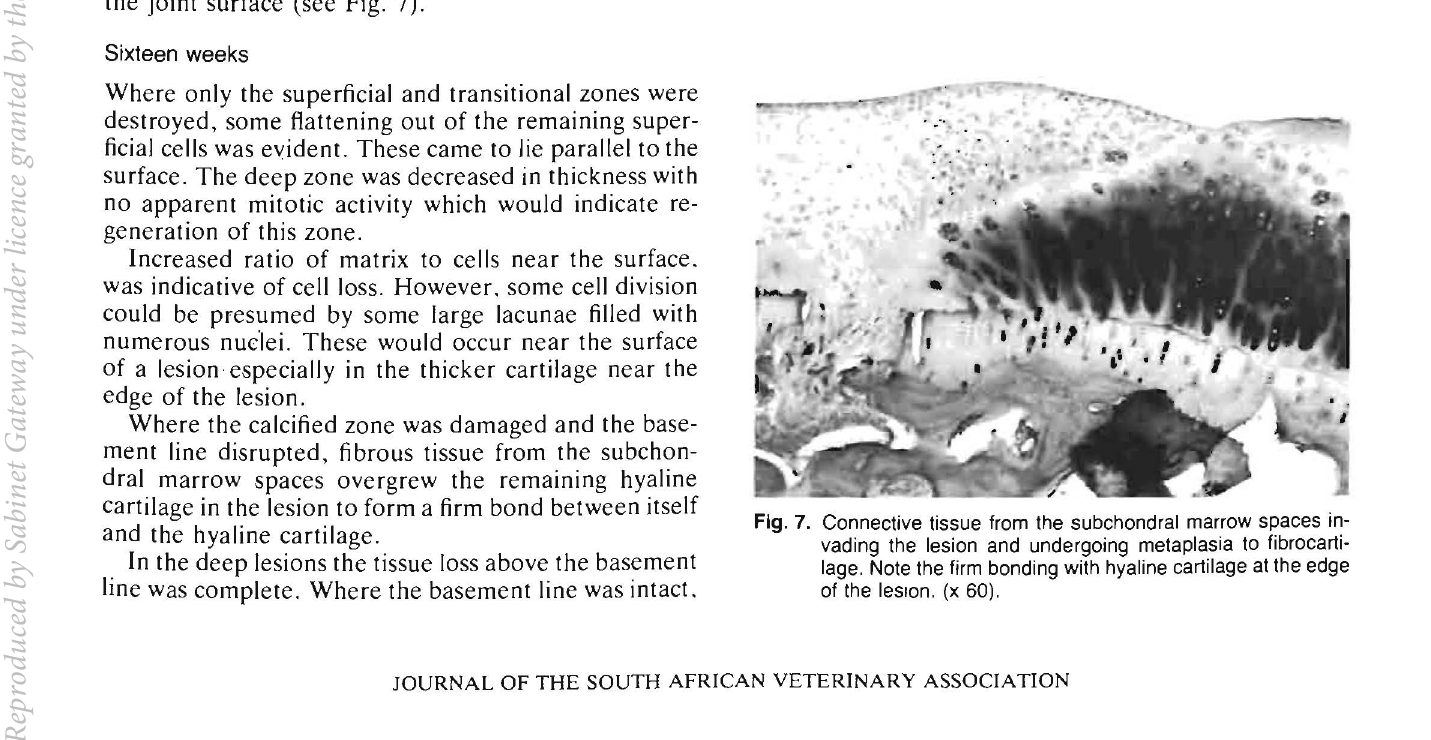
JOURNAL OF THE SOUTH AFRICAN VETERINARY